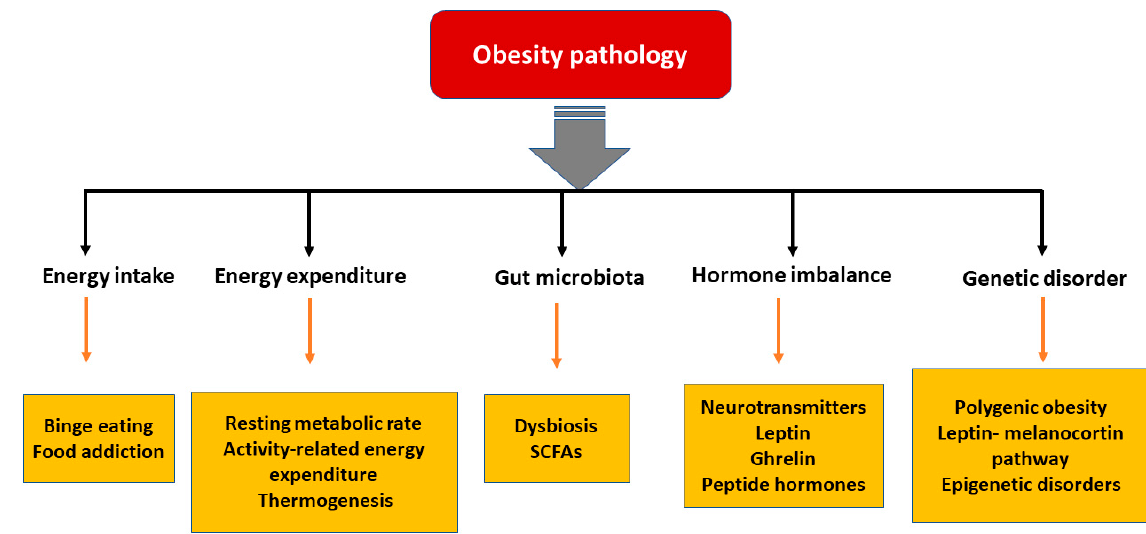
Figure 1. Various parameters affecting the pathology of obesity. [SCFA: short chain fatty acids].